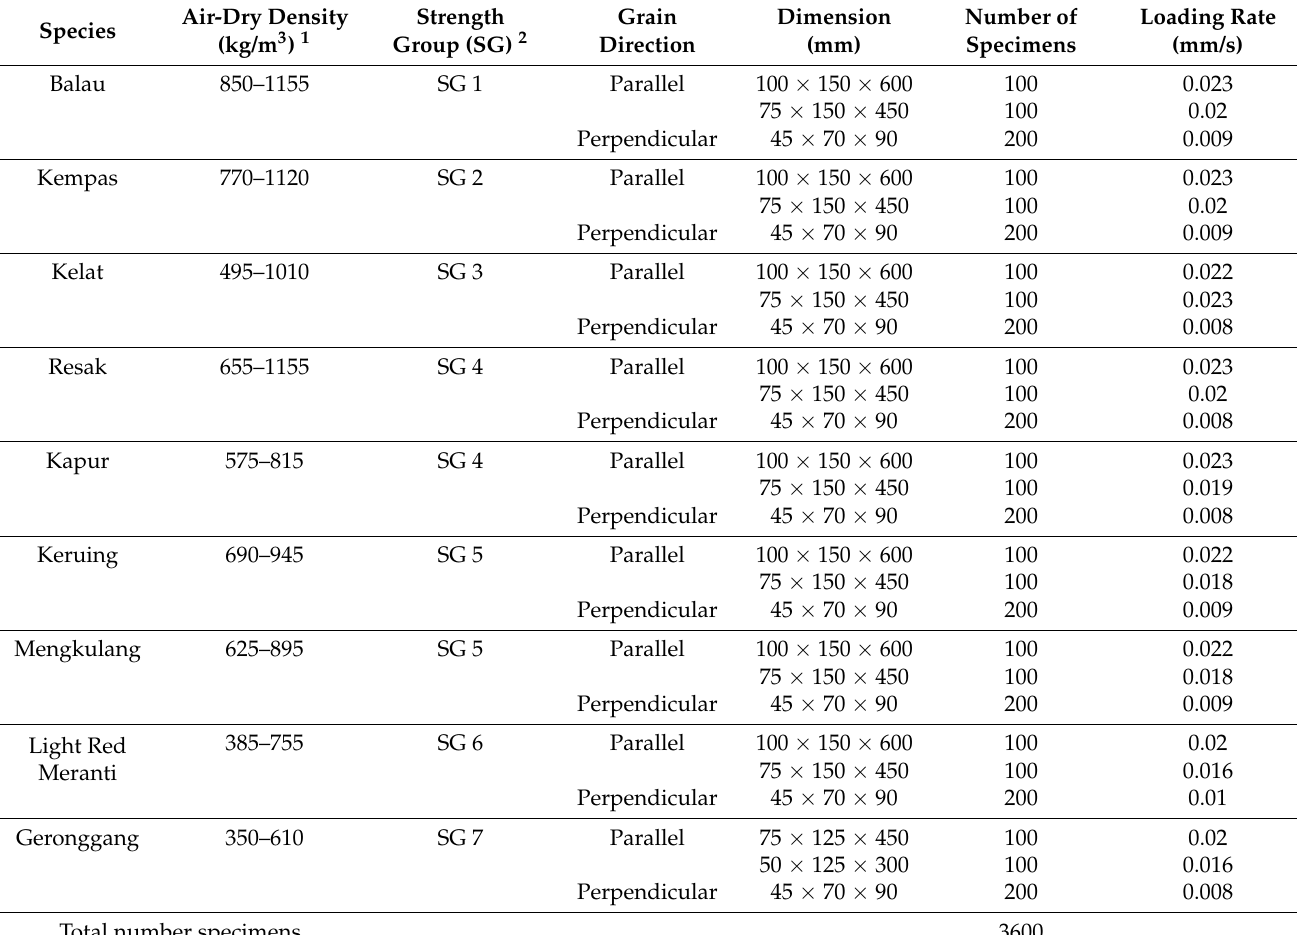
Table 1. Densities, strength group, dimension and number of specimens